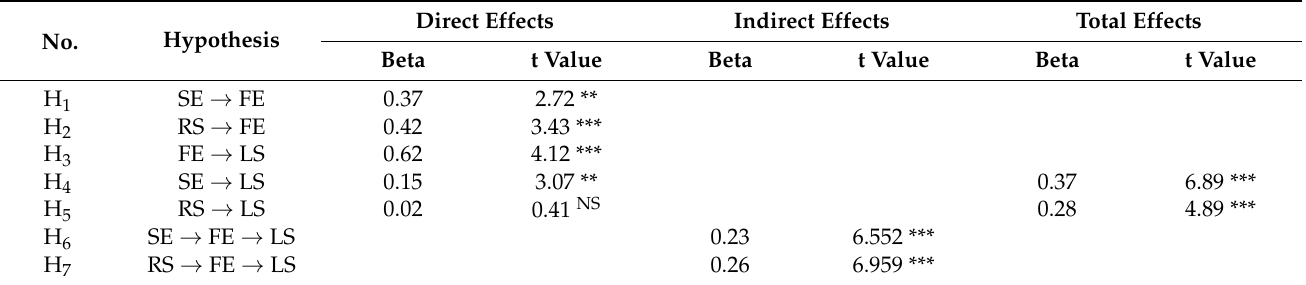
Table 3. Direct effect and indirect effect in the proposed research